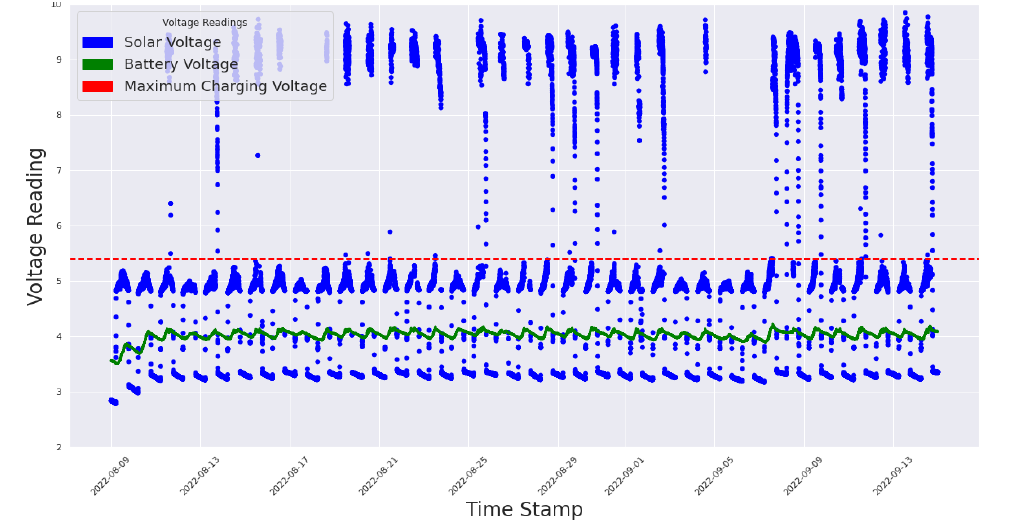
Figure 16. Sample visual of the recorded battery and solar voltages for one outdoor